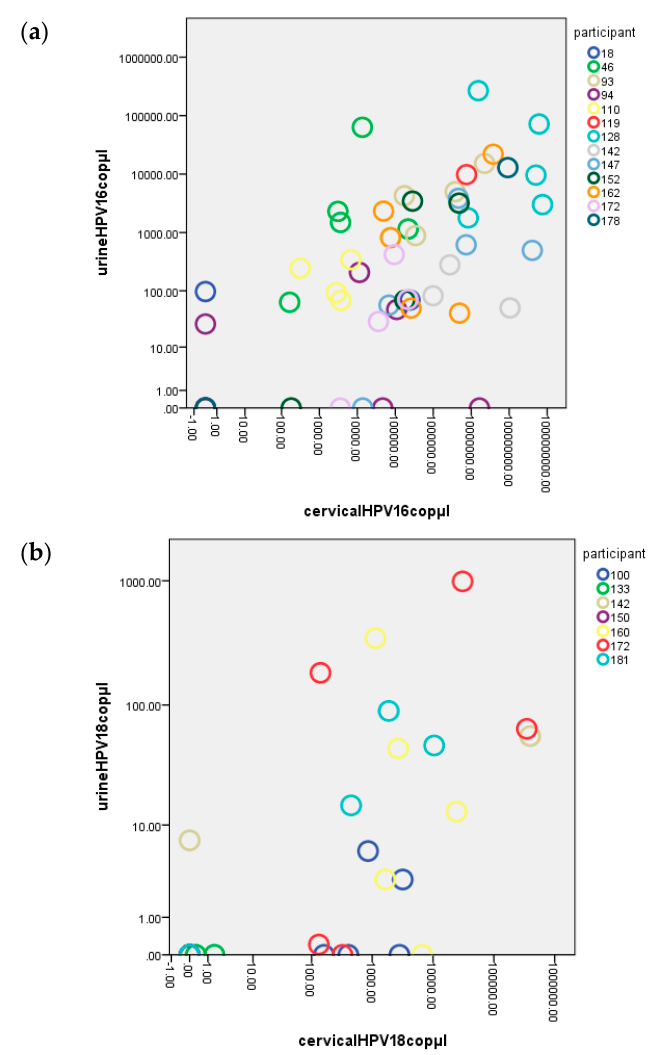
Figure 2. HPV copies in urine samples versus cervical samples: HPV16 ( A ) and HPV18 ( B ).